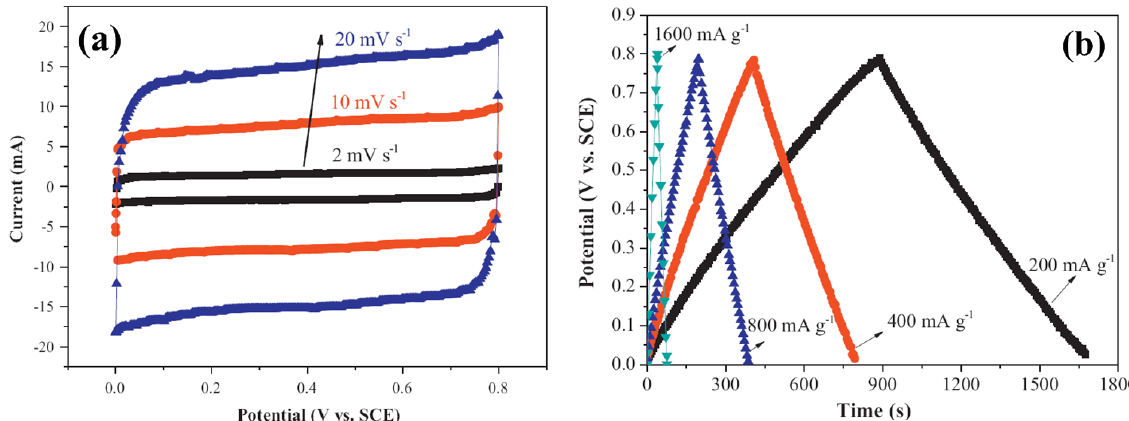
Figure 3. ( a ) CVs of MnO 2 at scan rates of 2, 10, and 20 mV·s − 1 ; and ( b ) Galvanostatic charge/discharges (GCDs) of MnO 2 at current densities of 200, 400, 800, and 1600 mA·g − 1